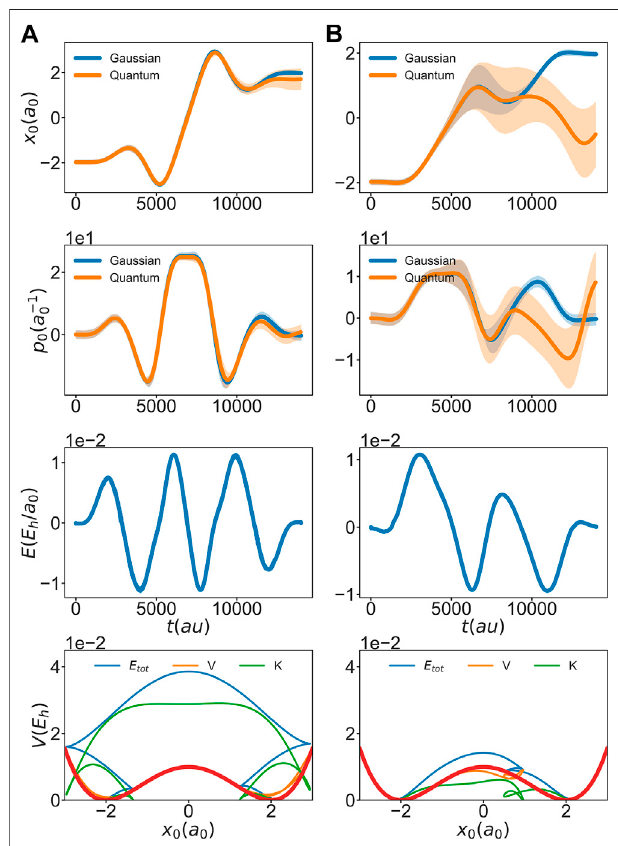
FIGURE 6 | Expectation values of coordinate and momentum (shaded areas indicate the standard deviation), optimal fi eld, as well as total ( E tot ), potential( V )andkinetic( K )energyofthemovingwavepacket (rowsfromtop to bottom) for t f (cid:1) 14 , 000auand (A) 6 m H , (B) 7 m H .Inthebottomrow the expectation values are plotted at the respective positions of the Gaussian wavepacket.